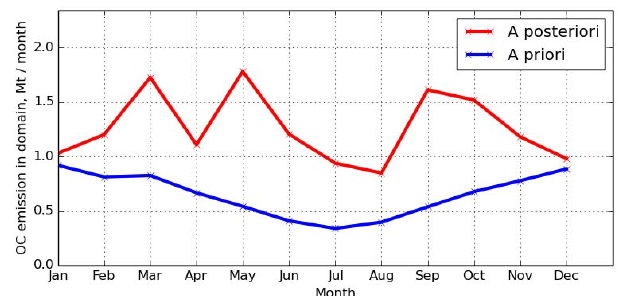
Figure 10. Monthly emissions of OC in Asia, total 2008, unit = MtPMmonth − 1 . Annual average OC mass: a priori: 7.8 × 10 9 kg; a posteriori: 1.5 × 10 10